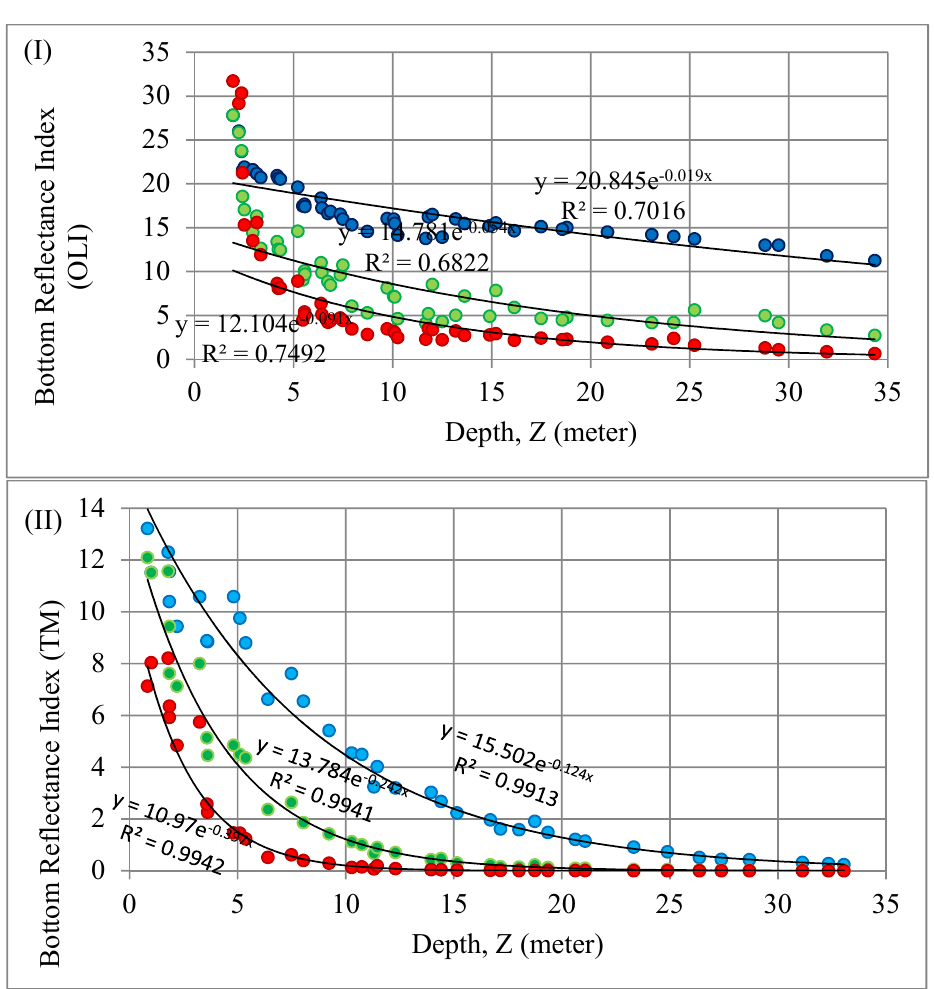
Figure A5. BRI exponential relationships to various water depths ( n = 45) in both Landsat images, L8-OLI (I) and L5-TM (II), and Seagrass mostly live in ≤ 5 m in this area. Thus, BRI range for seagrass can be seen through this figure. Similar to Table 9, in this range, low BRI indicates high STAGB, and vice versa . Muddy and sandy flat surface represented by very low BRI range ( ≤ 2 for TM, ≤ 5 for OLI). The middle range consists of shallow substrates heterogeneity at rocky area including submerged seaweed and rocks of different shapes and sizes, confirmed using underwater video in the identification of sea bottom features.